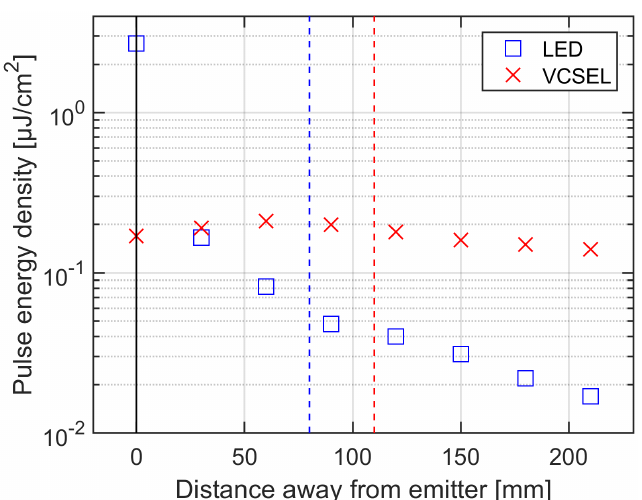
Figure 5. Energy density measurements as function of distance away from the emitter for the LED (c.f. Figure 2), and away from the plano-concave lens for the VCSEL illumination system (c.f. Figure 3). The object planes for both illumination systems are indicated as dashed-lines, blue for LED and red for the VCSEL